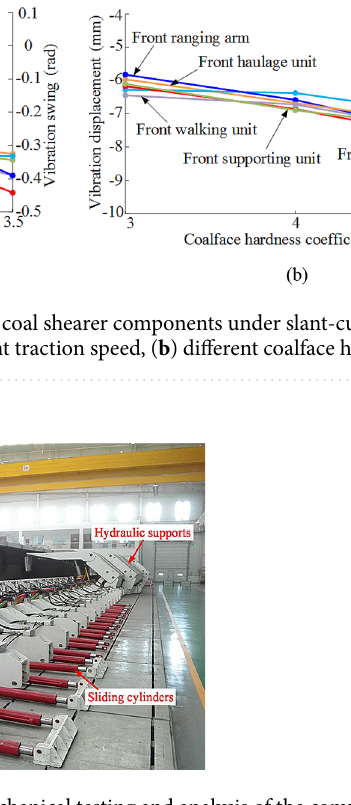
Figure 11. Experimental platform for mechanical testing and analysis of the comprehensive mining